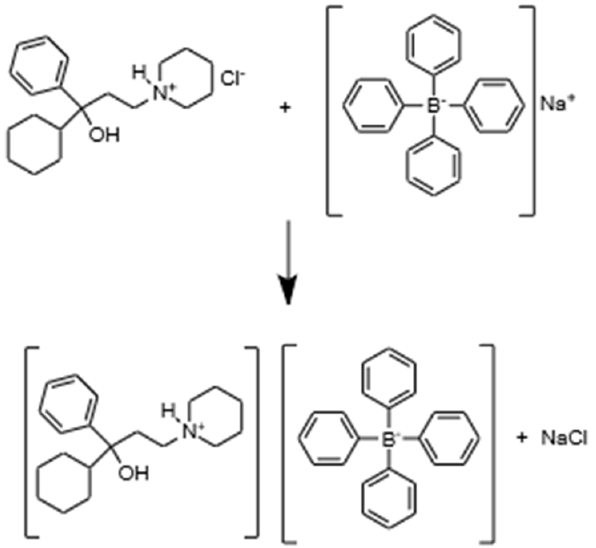
Figure 1. Proposed schematic diagram of reaction between THP × HCl and NaTPB ion pair associated complex as sensing element.